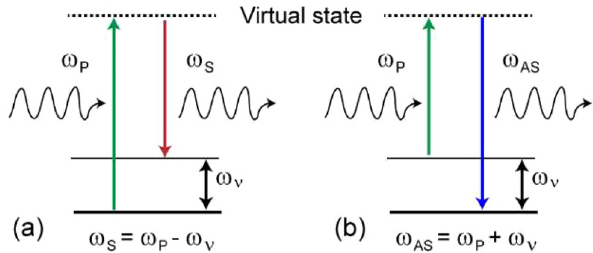
Figure 4: Stimulated Raman scattering can generate Stokes and anti-Stokes frequencies. (a) For a Stokes shift, energy from the incident photon is lost to vibrational modes of the material and a lower frequency (longer wavelength) photon is scattered. (b) For an anti-Stokes shift, the incident photon gains energy from the vibra- tional modes of the material and the scattered photon has a higher frequency (shorter